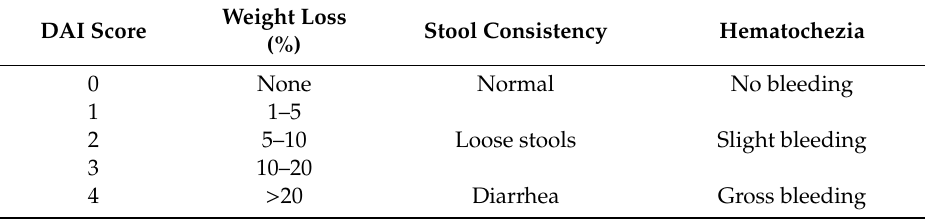
Table 1. Evaluation of